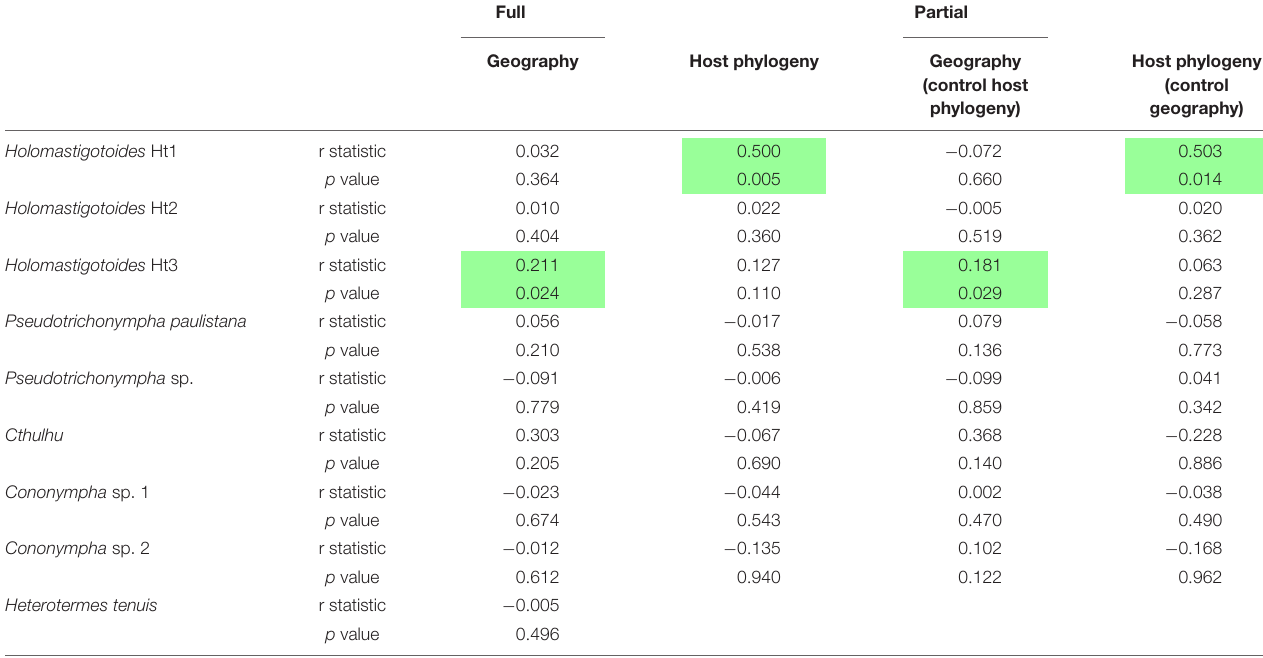
TABLE 1 | Mantel test results (coefficient of correlation, R, and p -values).